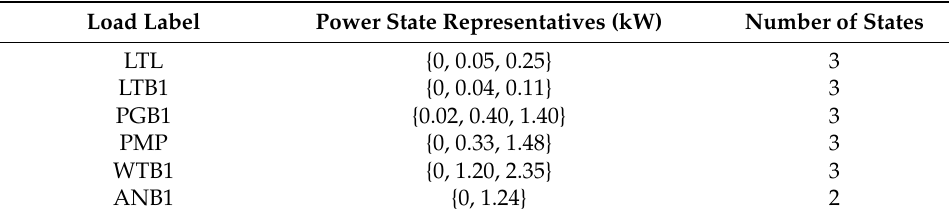
Table 2. Power state representation of appliance label using KDE plot. Load Label